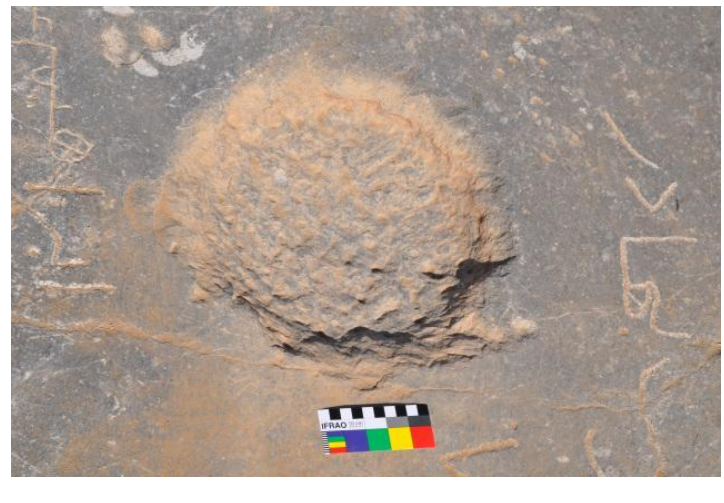
Figure 11. Ghārā-Tepe I, cupule-like